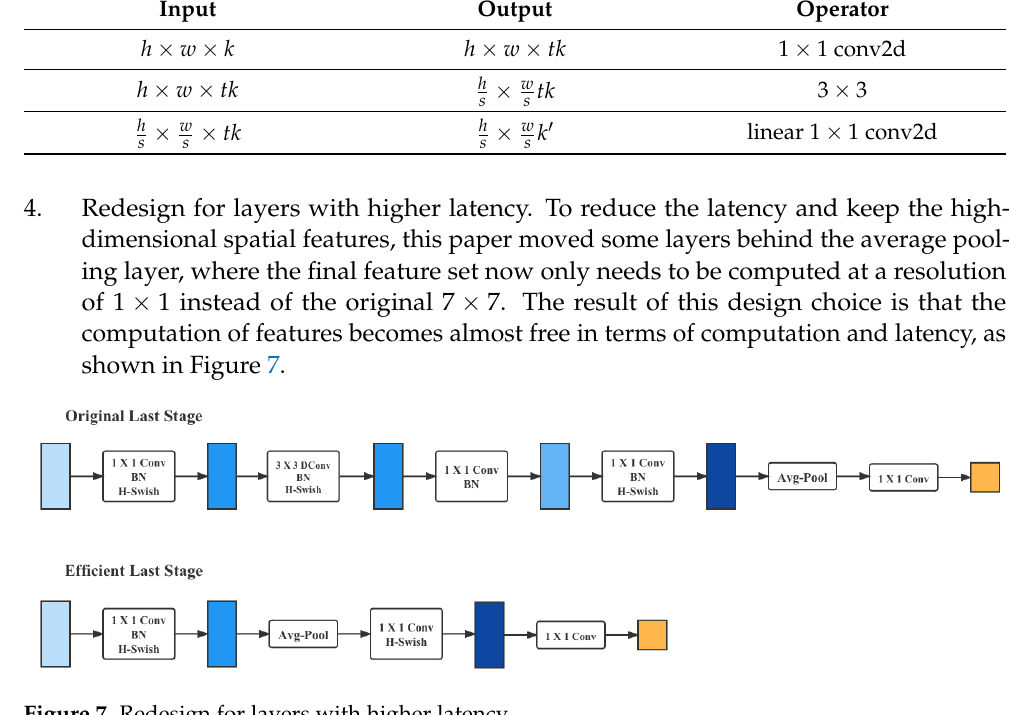
Figure 7. Redesign for layers with higher